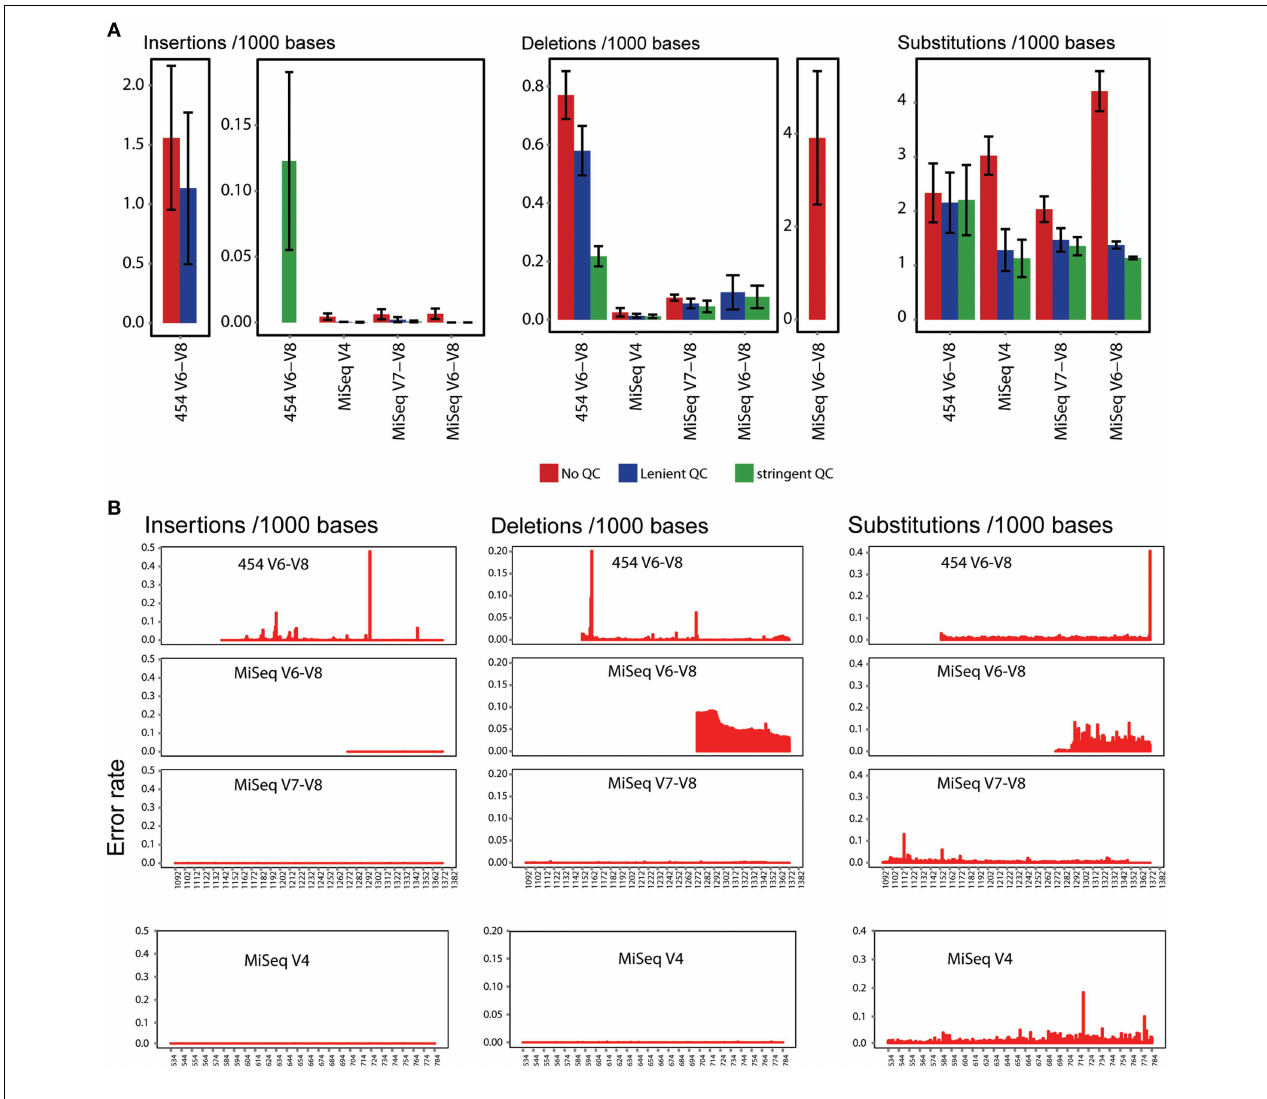
each sequencing condition. Error bars represent standard deviation. (B) Position of insertion, deletion and substitution error frequency in 16S tag amplicon sequences in which no QC filter has been